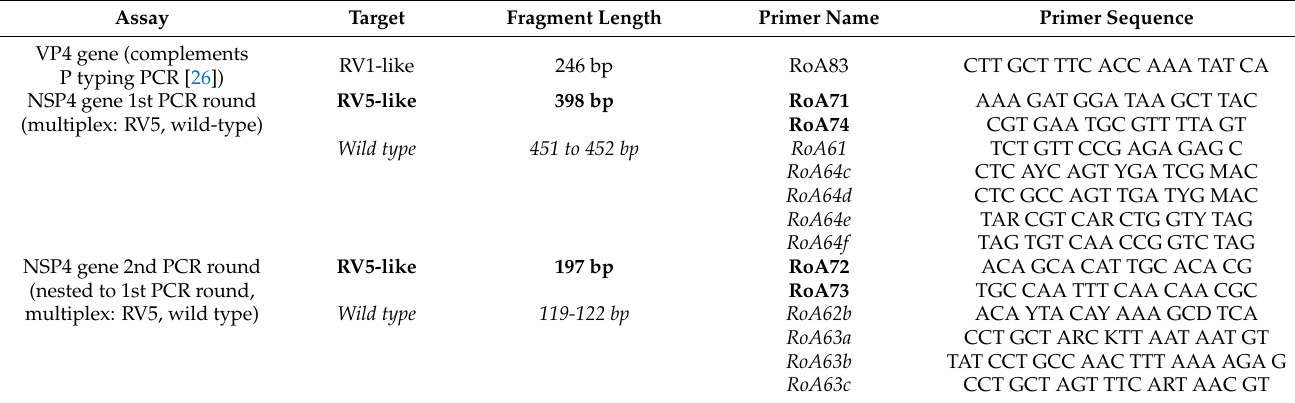
Table 1. Primers and probes used for algorithm of RVA